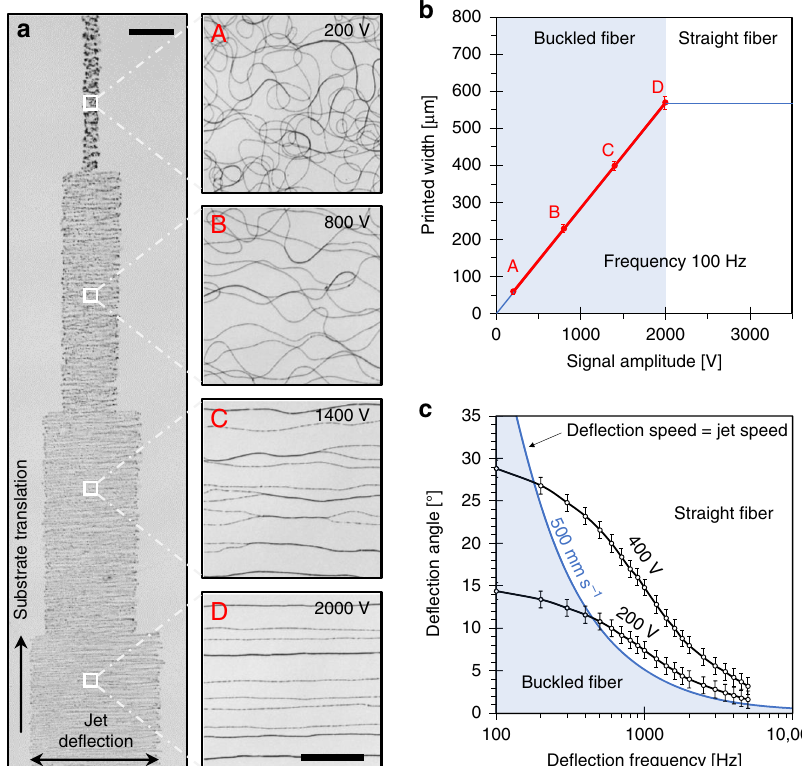
Fig. 2 Role of jet de fl ection parameters. a Optical photographs of the PEO fi ber collected as the substrate is moved at 1 mm s − 1 and the jet is de fl ected with a frequency of 100 Hz. The stepwise increase of amplitude of the jet de fl ection signal resulted in a stepwise increase of width of the PEO pattern, fi ber straightening and alignment. The amplitude of the jet de fl ection was varied from 200 V to 2000 V as depicted in the micrographs and the two electrodes were located at 10 mm from the default jet trajectory. Scale bars are 200 µ m on main panel and 25 µ m on magni fi ed panels. b Dependence of the width of the printed pattern on the signal amplitude at a fi xed frequency of 100 Hz. The blue shaded area displays the amplitude range where fi ber buckling would be obtained at this fi xed frequency. The four points in red correspond to the four amplitudes experimentally tested and presented in a . At the lowest amplitude that provides straight fi bers, the printing speed and the jet speed are matched (point D) and the jet speed can be computed as a product of the fi ber length printed in one de fl ection period times the printing frequency. At this amplitude, the width of the printed pattern reaches a plateau and it cannot be increased by increasing the signal amplitude. c Experimental dependence of the jet de fl ection angle on the jet de fl ection frequency for two different jet de fl ection amplitudes, 200 V and 400 V (two opposing electrodes located at 3 mm from the default jet trajectory). A blue line corresponding to a jet de fl ection speed of 0.5 m s − 1 is also plotted. The blued shaded area displays the region providing a jet de fl ection speed below 0.5 m s − 1 , thus jets traveling at this speed would result in fi ber buckling. Error bars were determined using the standard error of the mean of fi ve or more